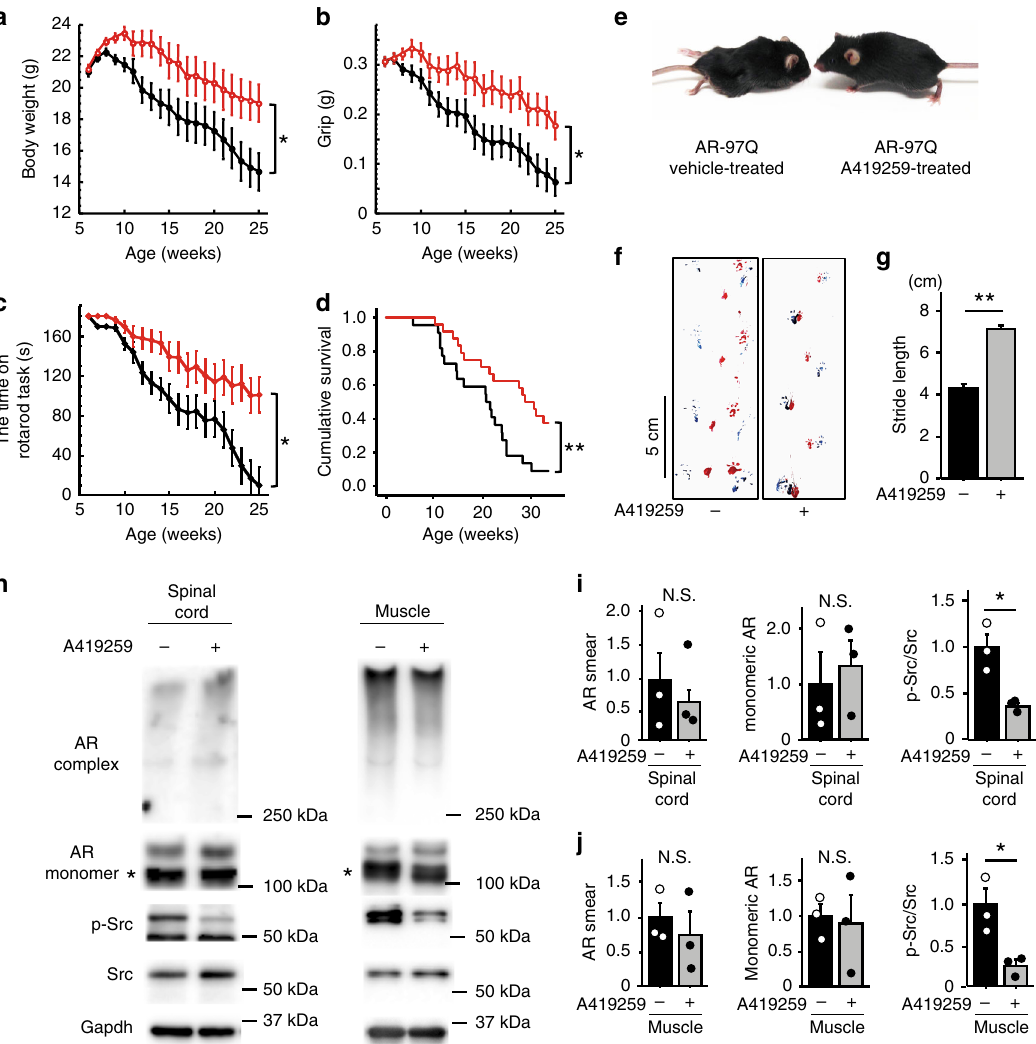
Fig. 4 A419259 improves the neuromuscular phenotype of the mouse model of SBMA. a – d Body weight ( a ), grip strength ( b ), rotarod performance ( c ) and survival rate ( d ) of A419259-treated ( n = 24) and vehicle-treated AR-97Q mice ( n = 22). All parameters improved after treatment with A419259 (* p < 0.05 at 13 weeks, as determined by the unpaired two-sided t -test for body weight, grip power and rotarod performance; ** p < 0.01 by the log-rank test). e Muscle atrophy and kyphosis in 13-week-old A419259- and vehicle-treated AR-97Q mice. f Footprints of 13-week-old AR-97Q mice. The front paws are indicated in red, and the hind paws are indicated in blue. g The length of steps taken by 13-week-old AR-97Q mice ( n = 3 animals per group). The columns show the average step length of the hind paw. h – j Immunoblots for AR, p-Src, and Src in the spinal cord and skeletal muscle of 13-week-old AR- 97Q mice treated with or without A419259 ( h ). Quantitative analyses were performed using densitometry ( n = 3 animals per group) ( i , j ). Black lines indicate vehicle-treated mice and red lines indicate A419259-treated mice ( a – d ). Error bars indicate the s.e.m. * p < 0.05 and ** p < 0.01, un p aired two-sided t -test ( g , i , j ). N.S., not signi fi cant. *, Non-speci fi c bands. Source data are provided as a Source Data fi le ( a – d , g – j